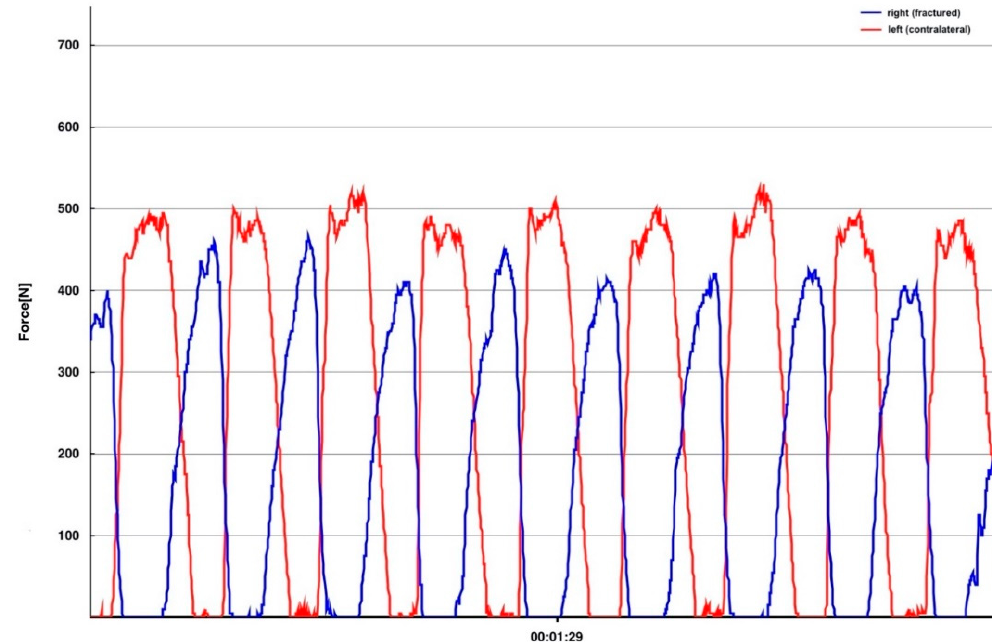
Figure 2. Comprehensive classification of fragility fractures of the pelvis according to Rommens and Hofmann [7]. Figure 1 is adapted from Ueda, Y. et al. [9] with permission from Springer Nature, 2020. FFP type I: anterior injury only. FFP type II: non-displaced posterior injury. FFP type III: displaced unilateral posterior injury. FFP type IV: displaced bilateral posterior injury.